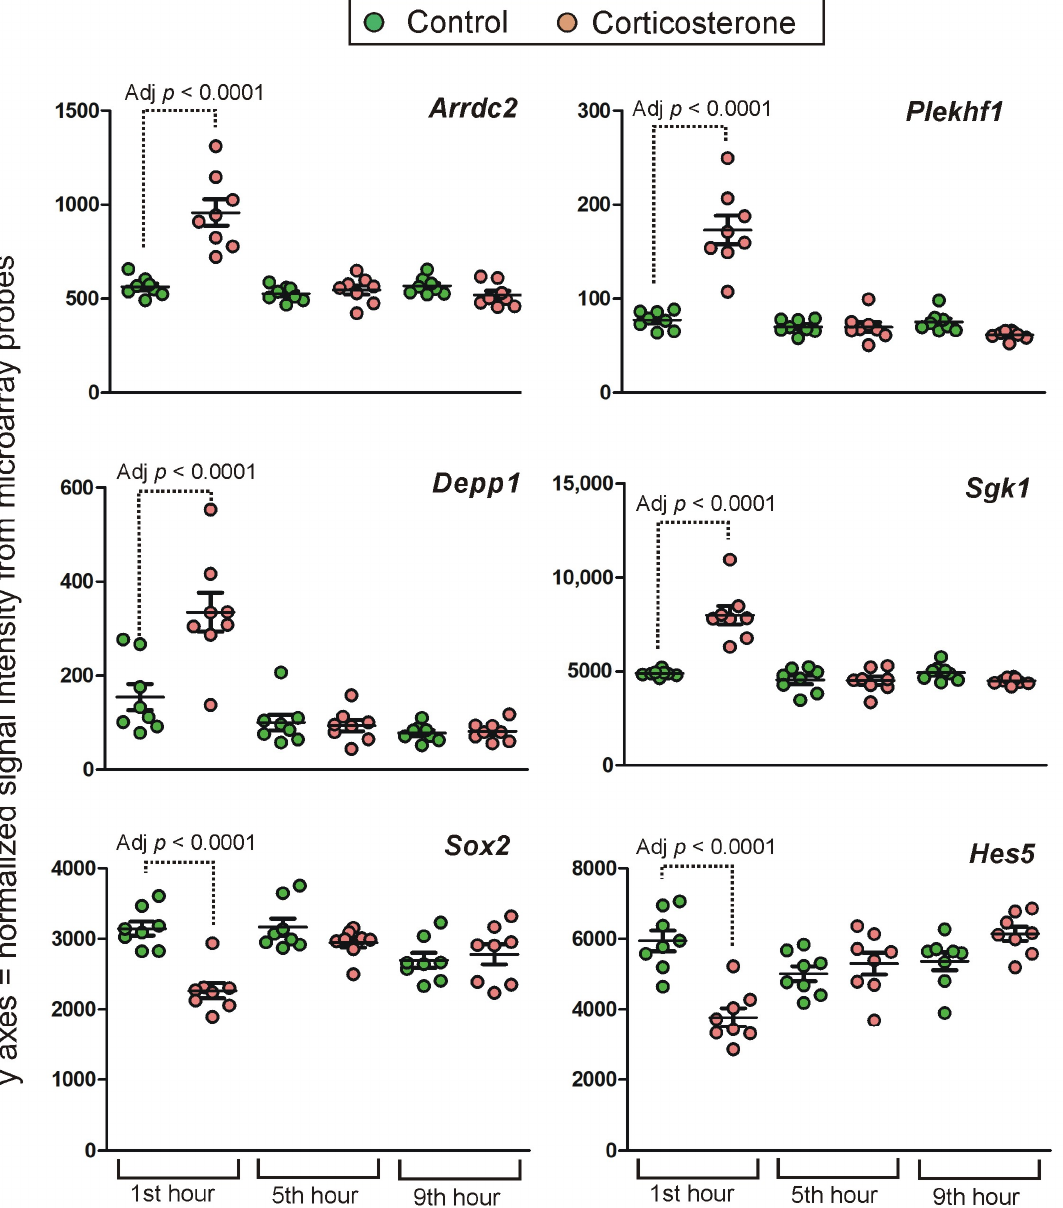
Figure 12. Examples of genes displaying short-lasting primary effects. Y axis indicates probe signal intensity decomposed into green and red channel after final background correction, within-array and between-array normalization. All data are available in File S1.